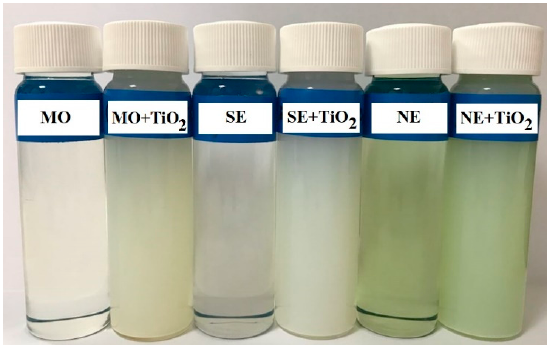
Figure 4. Comparison of prepared samples of Span ® 20 and titanium dioxide TiO 2 -based nanofluids with samples of base liquids; from the left: MO—mineral oil, MO + TiO 2 —mineral oil doped with TiO 2 , SE—synthetic ester, SE + TiO 2 —synthetic ester doped with TiO 2 , NE—natural ester, NE + TiO 2 —natural ester doped with TiO 2 .